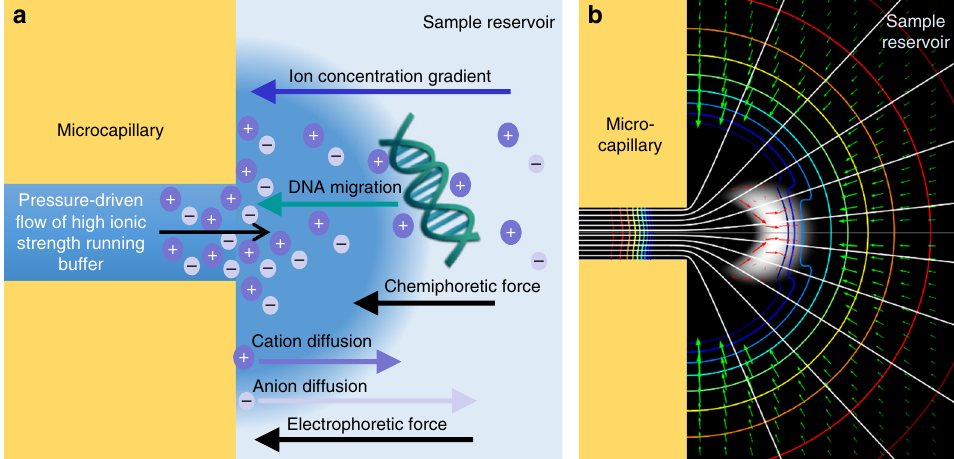
Fig. 2 Mechanism of DNA Molecular Rheotaxis (MRT). a Schematic of the underlying mechanism of MRT. Pressure-driven fl ow drives the high ionic strength running buffer out of the capillary into the low ionic strength reservoir buffer. This forms a concentration gradient of ions surrounding the capillary ori fi ce. The cations and anions migrate down their concentration gradients per their individual diffusivities. If anions diffuse faster than the cations, and induced electric fi eld is generated that causes DNA to migrate toward the higher concentration of ions at the capillary ori fi ce. Simultaneously, positive interactions between negatively charged DNA and cations can induce a chemiphoretic DNA migration towards the higher cation concentration near the capillary. b Results from the simulation show that fl ow out of the capillary (white streamlines emanating from microcapillary) is accompanied by an induced electric fi eld (concentric rainbow contour lines) and results in DNA accumulation in a bolus near the capillary ori fi ce (white shading). The direction and magnitude of DNA fl ux from the reservoir toward the bolus is shown in green arrows and with red arrows within the bolus. The original image was mirrored across the centerline to view the whole capillary (for the original fi gure, see Supplementary Fig.